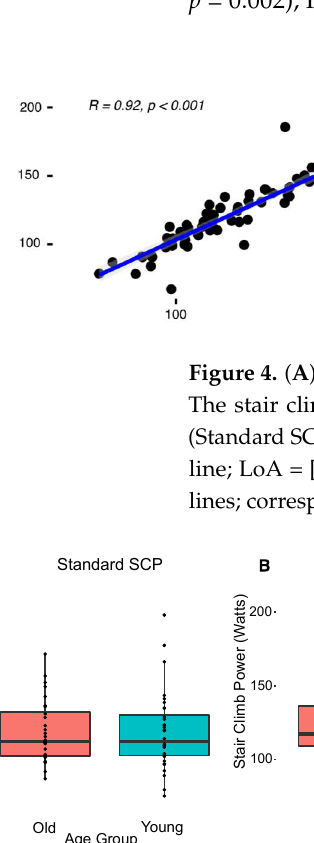
Figure 5. ( A ) The Standard SCP showed no significant differences between younger and older groups ( p = 0.96). ( B ) The StairPy derived SCP also showed no significant differences between younger and older groups ( p = 0.39). ( C ) The Standard SCP showed a significant effect between sex groups ( p = 0.002), with males exhibiting higher SCP values and likewise ( D ) the StairPy SCP showed a similar significant difference between sex groups ( p = 0.002).